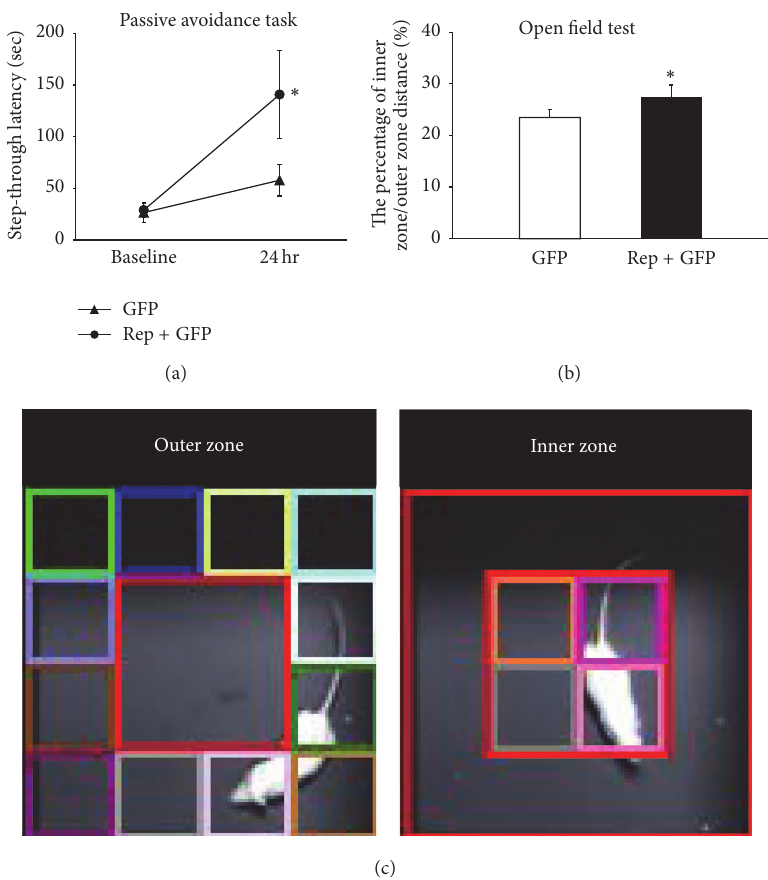
Figure 2: Effects of reprogramming factor expression on neurobehavioral functions after chronic hypoxic-ischemic brain injury. Passive avoidance task and open field test results showed that expression of the four reprogramming factors improved long-term memory and decreased anxiety 8 weeks after the treatment. (a) Expression of the four reprogramming factors significantly improved retention test performance 24 hours after an aversive stimulus 8 weeks after the treatment ( 140.9 ± 42.5 seconds) relative to that in the initial assessment ( 57.9±15.3 seconds), whereas the performance was not statistically improved in the control group ( 𝑡 = 2.916 , 𝑝 < 0.05 ; 𝑛 = 7 per group). The result suggests that the expression of reprogramming factors improves long-term memory 8 weeks after the treatment. (b) The total distance of movement was assessed for 15 min. The percentage of the inner zone/outer zone increased in the treatment group ( 27.4 ± 1.3 %) compared to the control group ( 23.5 ± 1.1 %) ( 𝑡 = 2.568 , 𝑝 < 0.05 ; 𝑛 = 8 and 𝑛 = 9 per group, resp.). (c) Among the total of 16 zones, 4 central zones are an inner zone, and 12 peripheral zones are an outer zone. ∗ 𝑝 < 0.05